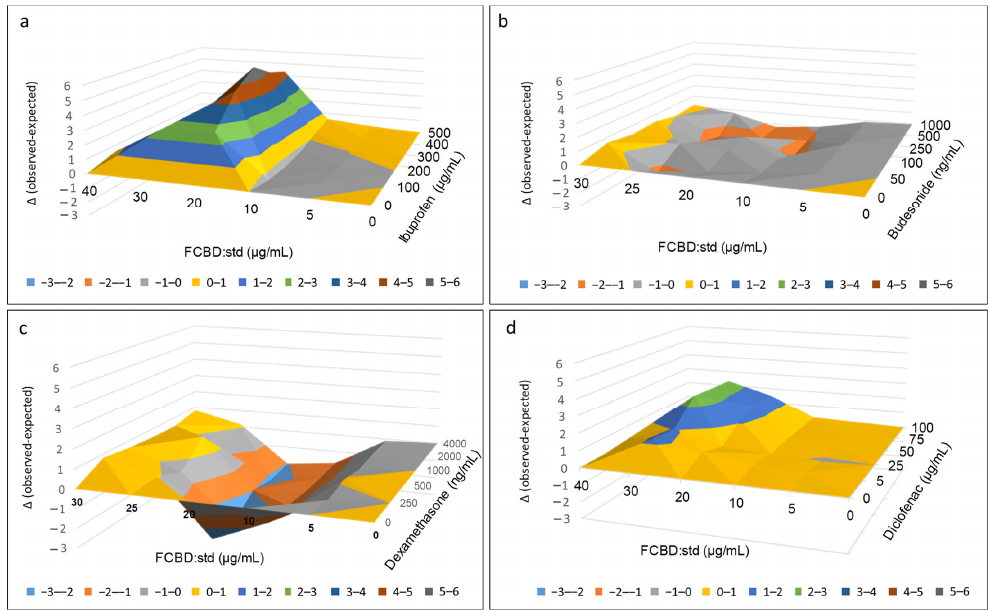
Figure 1. Synergistic interactions between FCBD:std with ( a ) ibuprofen, ( b ) budesonide, ( c ) dexamethasone or ( d ) diclofenac on KG1 cell IL-8 levels following combined treatments. The Bliss independence-drug interaction model was used to calculate synergy. Synergy is determined when the experimental value of IL-8 reduction is higher than the calculated value. In the Y axis is the delta between the experimental and the calculated values. In Supplementary Table S2, different letters indicate significantly different levels of the experimental (observed) values from all pairs’ combinations according to Tukey–Kramer honest significant difference test ( n = 3; HSD; p ≤ 0.05). Treatment with 30 µg/mL FCBD:std and 50 ng/mL budesonide showed a 2.0-fold higher activity than budesonide alone at this concentration (Supplementary Table S1b). However, the synergy (i.e., the delta value of the experimental [observed] value of IL-8 reduction minus the calculated [expected] value of the combination) between FCBD:std and budesonide was not significantly different in comparison to treatment with either FCBD:std or budesonide alone (Figure 1b; Supplementary Table S1b). Other combinations of FCBD:std and budesonide led to significant inhibition of activity (e.g., 25 µg/mL of FCBD:std and 500 ng/mL budesonide; Figure 1b; Supplementary Table S1b). Treatment with 30 µg/mL FCBD:std and 2000 ng/mL dexamethasone resulted in activity that was 3.7-fold higher than dexamethasone alone (Supplementary Table S1c). However, when compared to treatment with each component independently, the combined treatment activity was not significantly higher (Figure 1c; Supplementary Table S1c). Moreover, inhibition rather than activity enhancement was apparent in other combinations of FCBD:std and dexamethasone (e.g., 20 µg/mL and 250 ng/mL of FCBD:std and dexamethasone, respectively; Figure 1c; Supplementary Table S1c). Treatment with 30 µg/mL FCBD:std and 50, 75 or 100 µg/mL of diclofenac showed 1.2, 2.0 and 1.9-fold higher activity than diclofenac alone, respectively (Supplementary Table S1d). The synergy between FCBD:std and diclofenac was apparent mainly at 30 µg/mL FCBD:std and 50–100 µg/mL diclofenac (Figure 1d; Supplementary Table S1d).